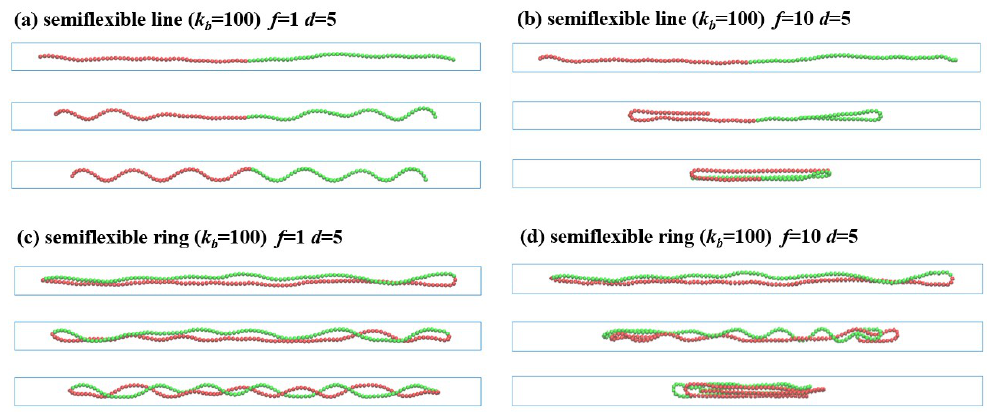
Figure 2. Compression of semiflexible polymers in a confined channel with diameter d = 5. ( a ) Linear chain under f / k B T = 1.0 with the end-to-end distance L x = 97.9,89.1,81.0 (from top to bottom). ( b ) Linear chain under f / k B T = 10.0 with L x = 98.0,54.5,32.0. ( c ) Ring chain under f / k B T = 1.0 with L x = 97.7,93.9,88.3. ( d ) Ring chain under f / k B T = 10.0 with L x = 97.3,60.1,35.1. The beads are labeled with red and green for